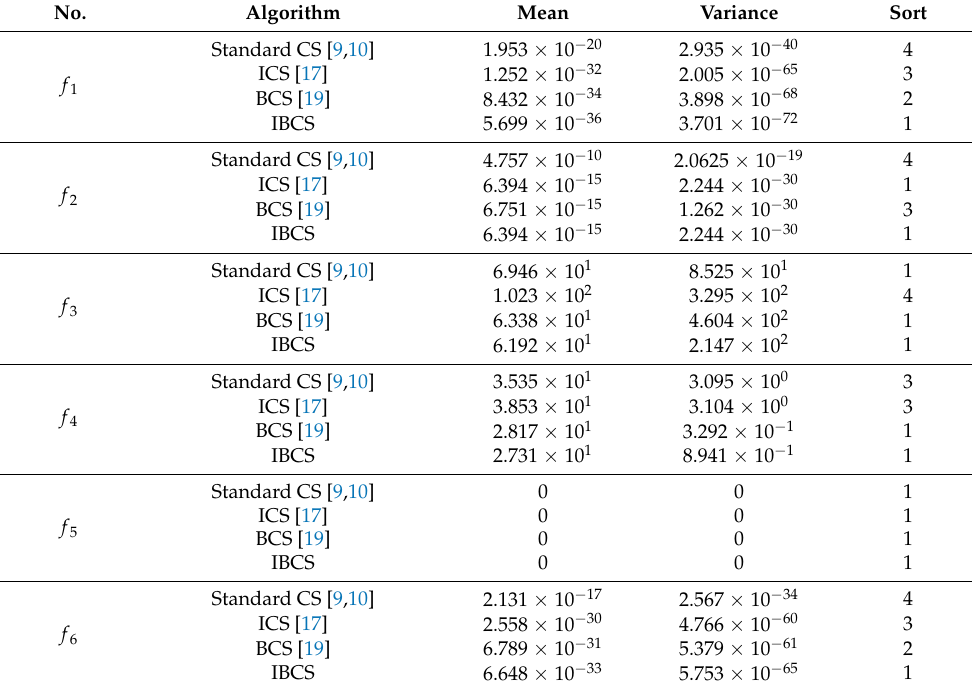
Table 3. Test results of four optimization algorithms on 50-dimensional test